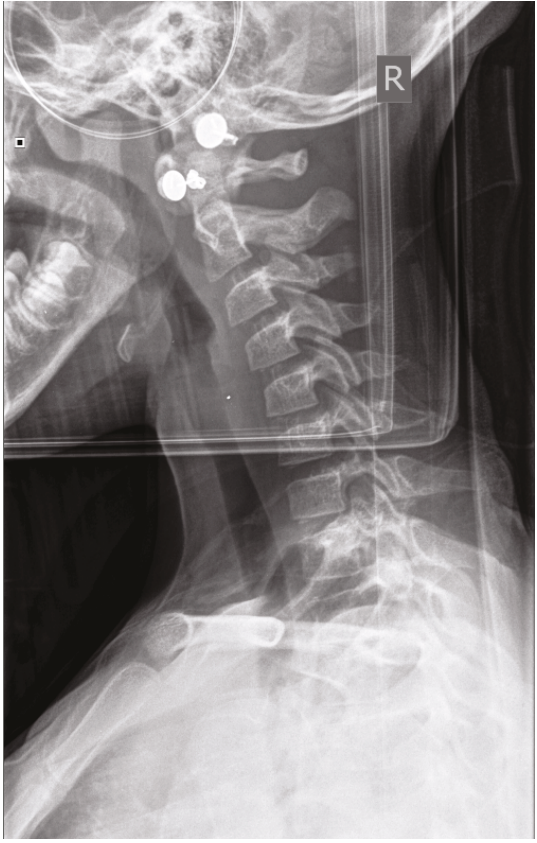
Figure 1: Lateral C-spine radiograph.